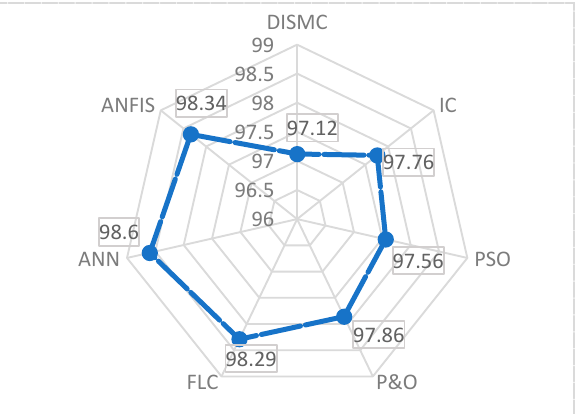
Figure 14. Efficiencies (%) of MPPT algorithms under steady-state weather conditions: Test 1.